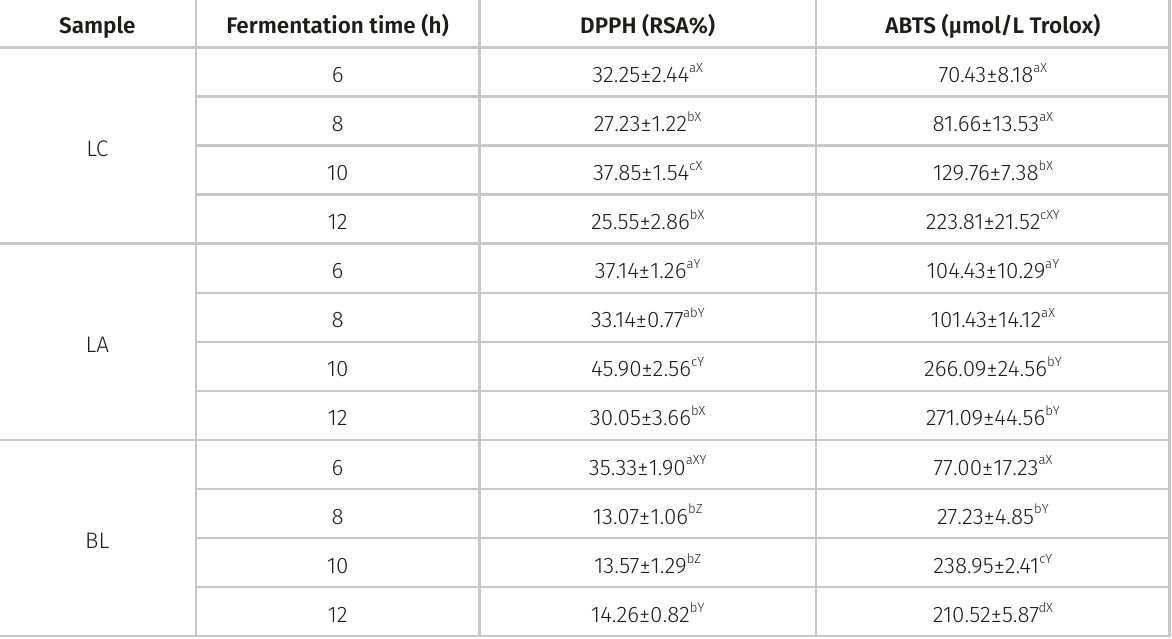
Table II. Antioxidant activities of LC, LA and BL samples during the fermentation time.